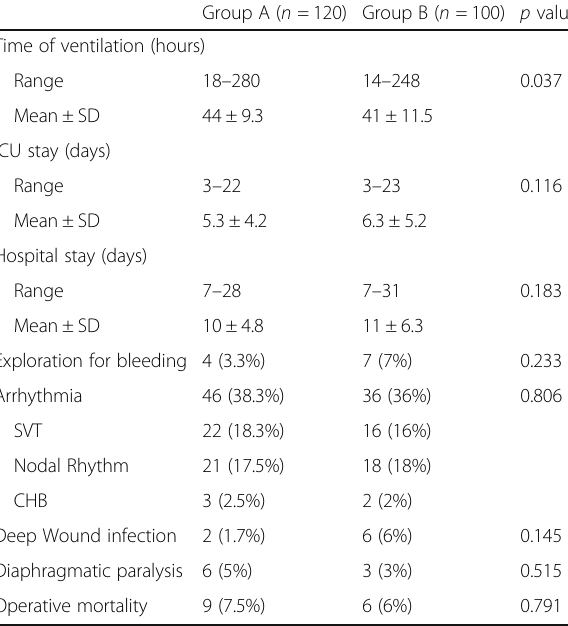
Table 3 Postoperative data. Table 1 Preoperative patients ’ data (continuous variables are